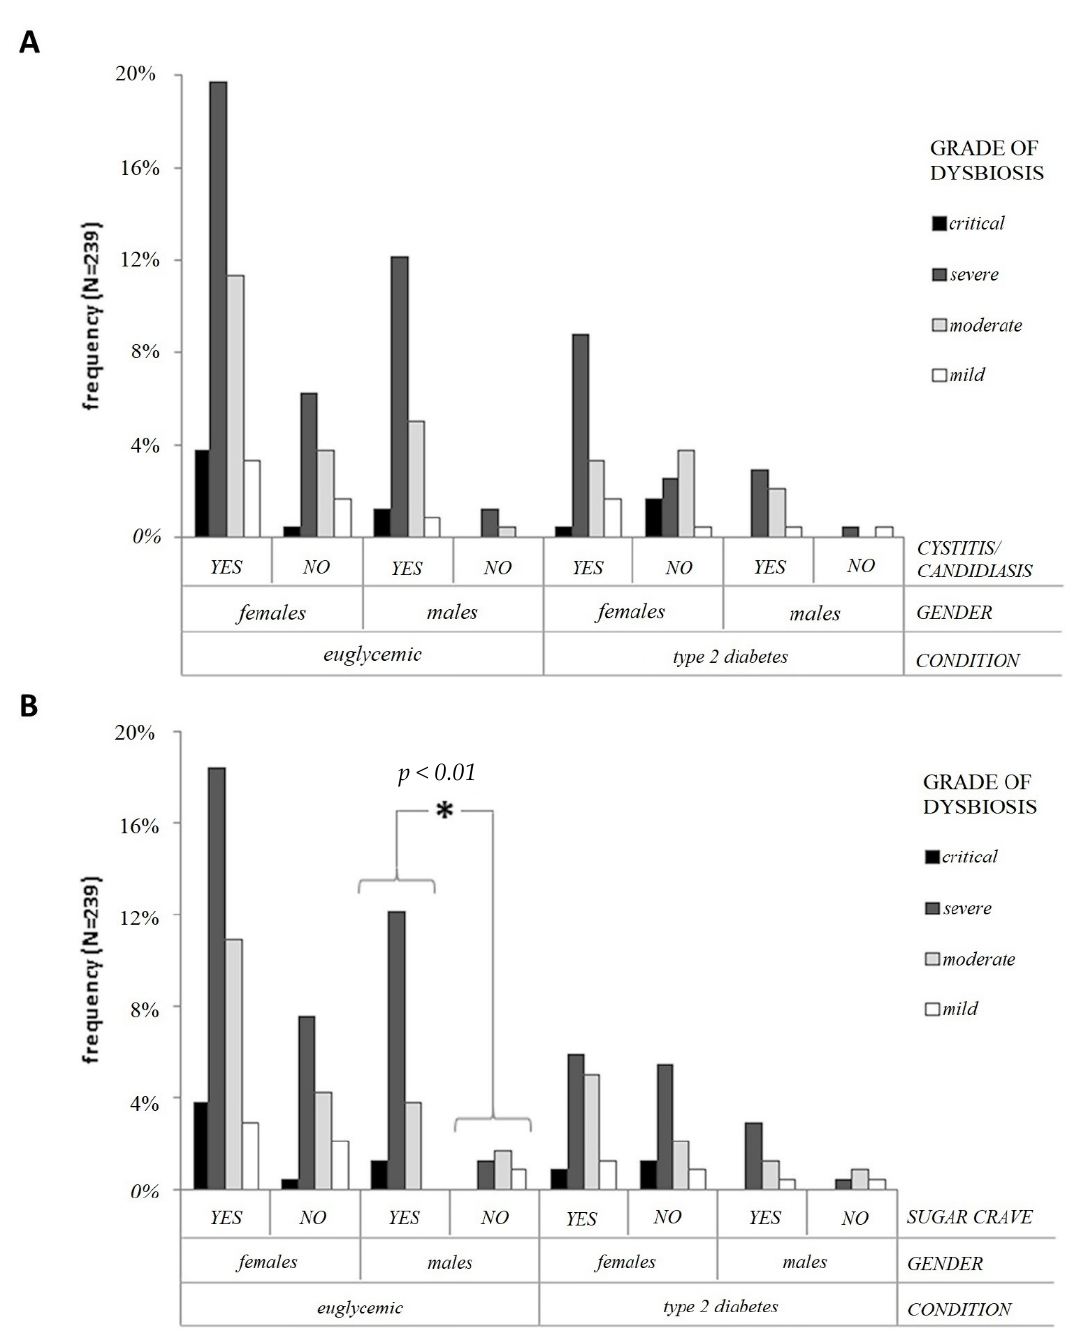
Figure 4. Panel ( A ) Association of cystitis/candidiasis in subjects with a grade of dysbiosis, controlled for gender and type 2 diabetes. Exact statistical significance was adopted. Panel ( B ) Association of sugar cravings in subjects with a grade of dysbiosis, controlled for gender and type 2 diabetes. The star marks the statistically different distribution of counts between non-diabetic males that show or do not show sugar cravings. p < 0.01 refers to exact statistical significance.